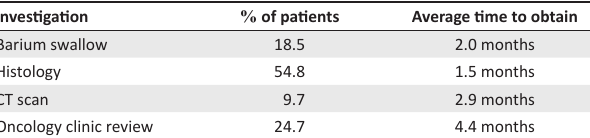
TABLE 2: Delay to individual investigations and non-standardised management (derived from chart review). Investigation